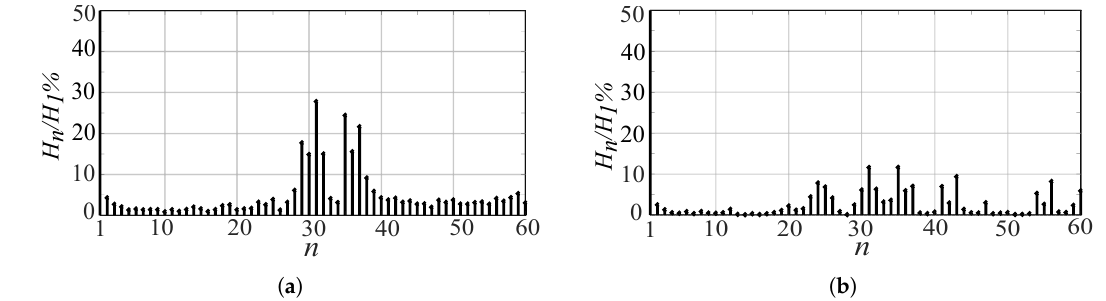
Figure 5. FFT of the output line-line voltage: ( a ) TLI. ( b ) 5-level inverter.